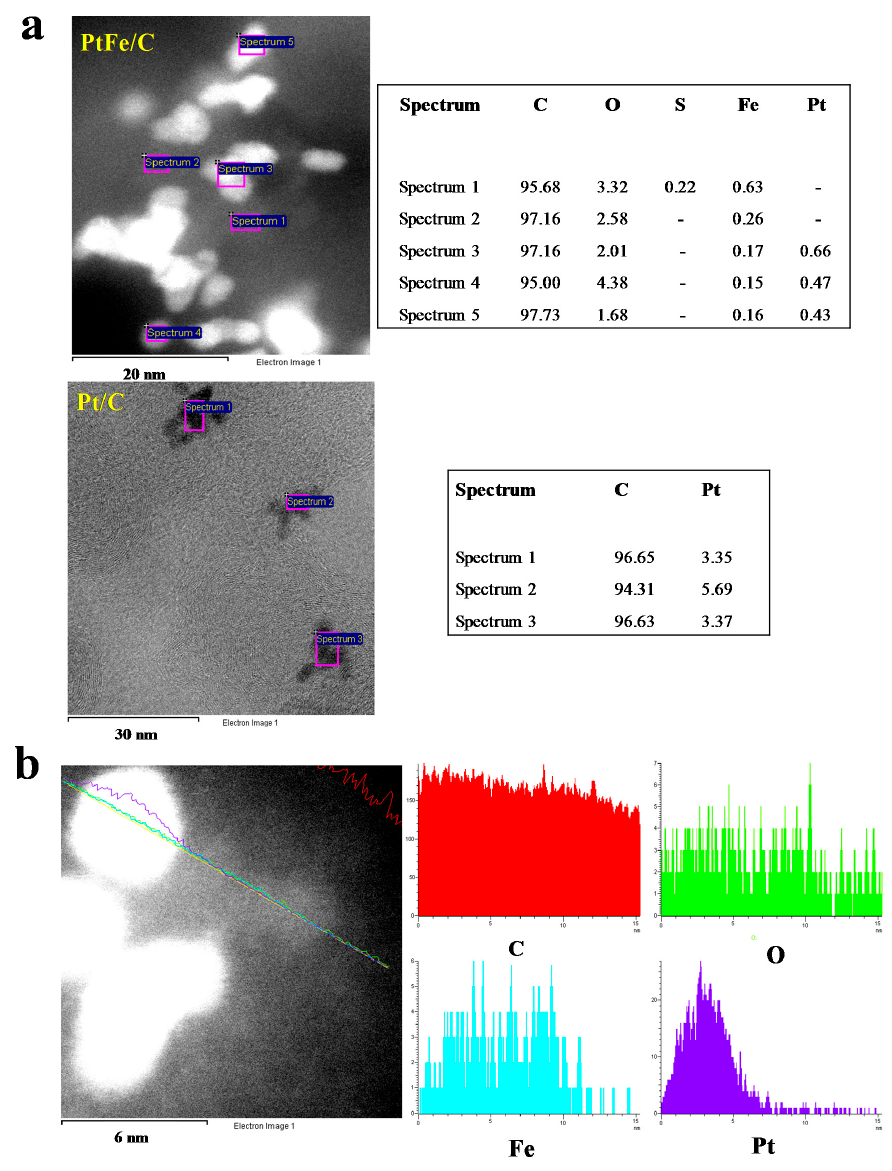
Figure 4. ( a ) EDX spectra of PtFe/C and Pt/C for a set of nanoparticles; ( b ) EDX line-scan of